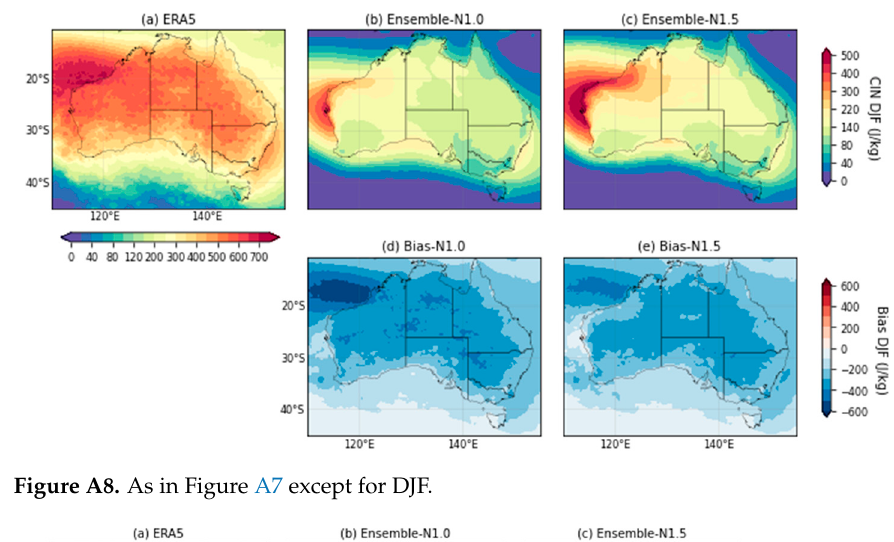
the biases of N1.0 and N1.5 from ERA5, respectively. Unit: J kg − 1 . biases of N1.0 and N1.5 from ERA5, respectively. Unit: J kg − 1 .